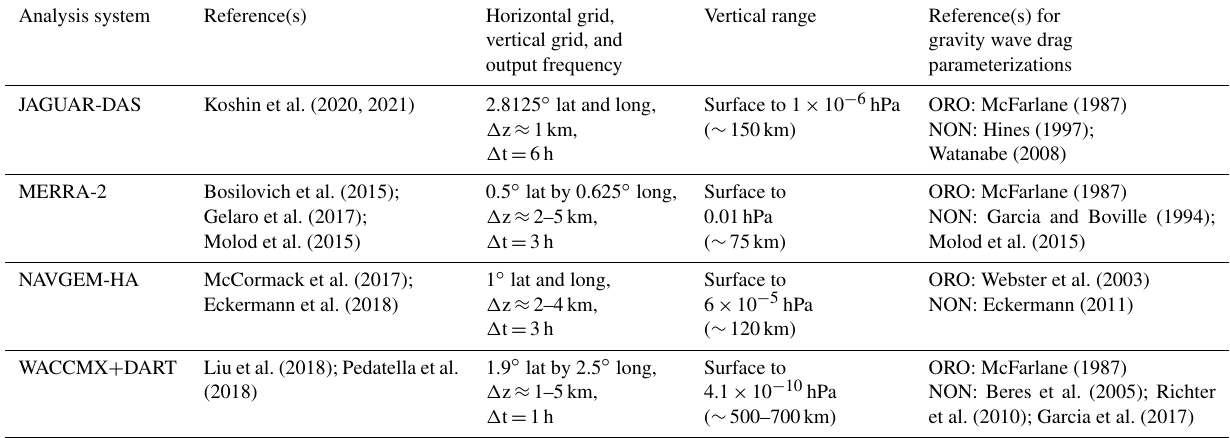
Table 1. List of analysis datasets used in this paper, overall references describing each system, the horizontal, vertical, and temporal char- acteristics of the analysis output, the model top, and references for gravity wave specifications. In the fifth column, ORO refers to the parametrization for orographic gravity waves, while NON refers to that of non-orographic gravity